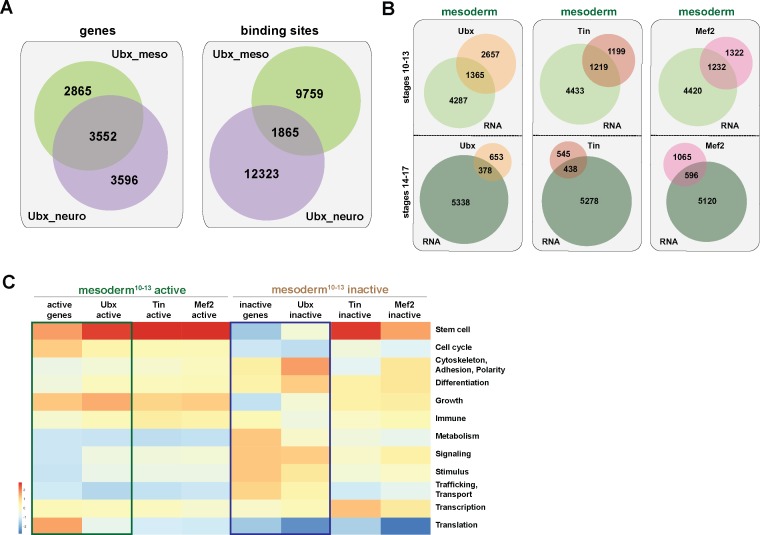
Ubx is a general regulator of mesoderm development.(A) Left panel: Venn diagram representing the overlaps between Ubx bound genes in mesodermal (green) and neuronal (purple) nuclei in stage 10–13 embryos. Right panel: Venn diagram representing the overlaps between chromatin regions bound by Ubx in mesodermal (green) and neuronal (purple) nuclei. (B) Venn diagrams representing the overlaps between the mesodermal transcriptome (green) and Ubx (orange), Tin (light red) and Mef2 (pink) bound genes at two different stages. (C) Heat-map displaying presence of genes belonging to higher-order categories in the different gene classes. The colour range corresponds to the centered and scaled (per column) fraction of genes annotated to the category that also appear in the sample: red colour represents high values, blue colours low fractions of genes in the category, which are also present in the sample. Rows and columns are hierarchically clustered using Euclidean distance with complete linkage. The blue and green boxes highlight the distributions of functional terms among the expressed and Ubx targeted as well as the inactive and Ubx-targeted genes.